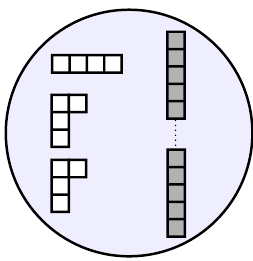
Figure 1 . A five-punctured sphere C for which the theory S [ A 3 , C ] is factorized. C contains one maximal puncture (represented by the Young diagram [1 4 ] ), two minimal punctures (represented by the Young diagram [3 , 1] ), and two minimal twisted punctures (represented by the Young diagram [5] ). There is a Z twist line (black dotted line) connecting the two twisted punctures. 2